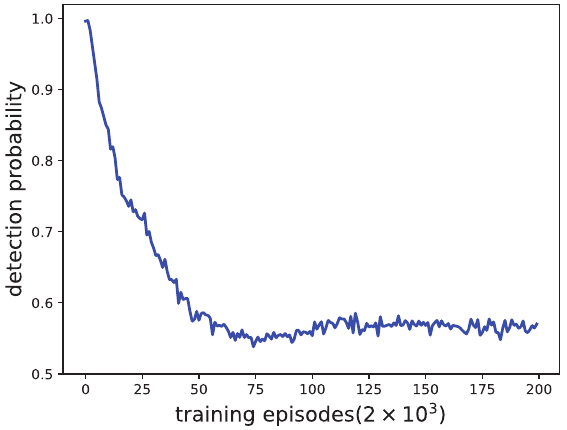
Figure 4. The detection probability curve.